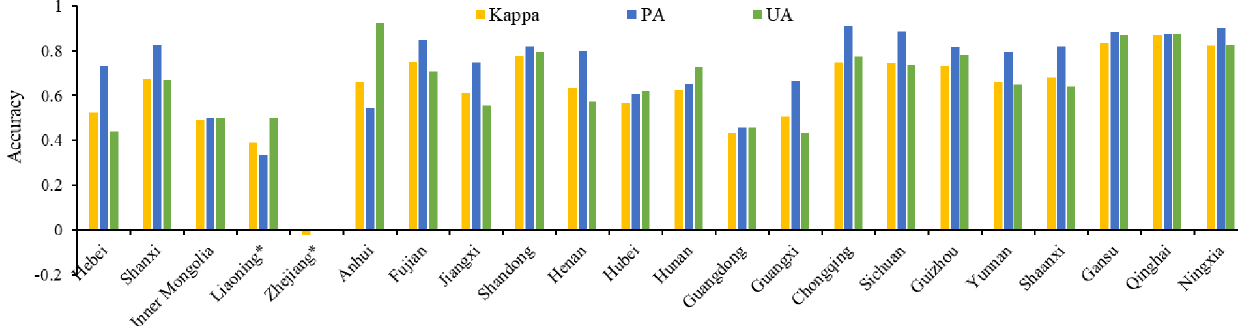
Figure 8. Kappa, PA of terrace class, and UA of terrace class for different